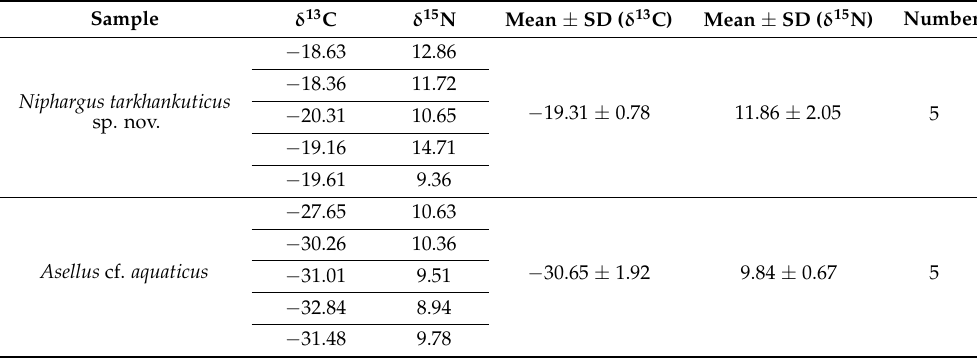
Table 1. Stable isotope ( δ 13 C/ δ 15 N ± SD) values (‰) for macrocrustaceans collected in the well